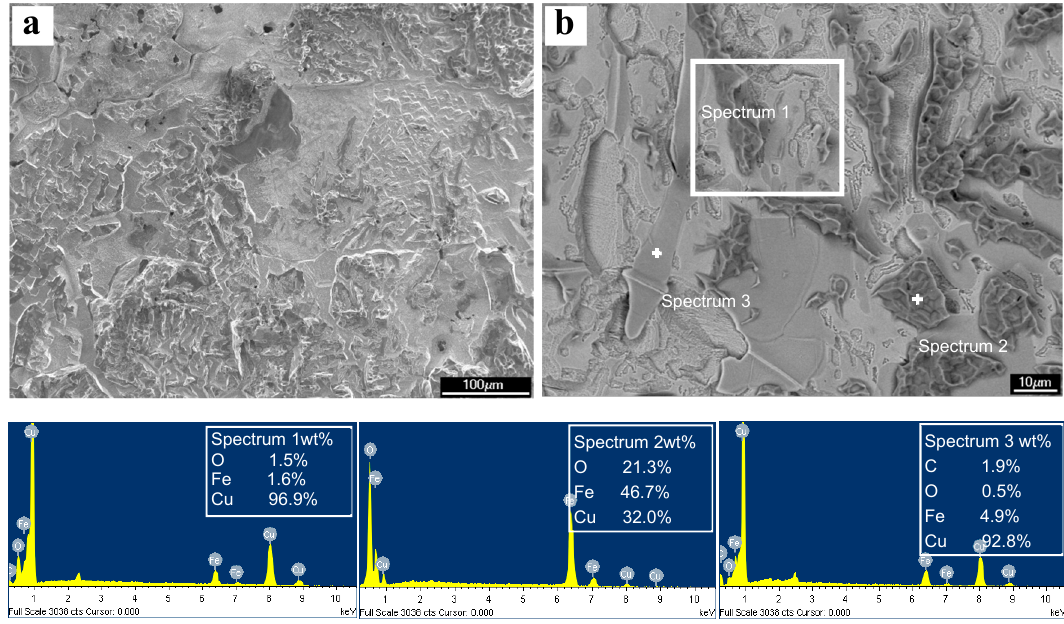
Figure 5. SEM ( a ) and BSE ( b ) micrographs and corresponding EDX spectra on the surface of steel 2 after descaling.